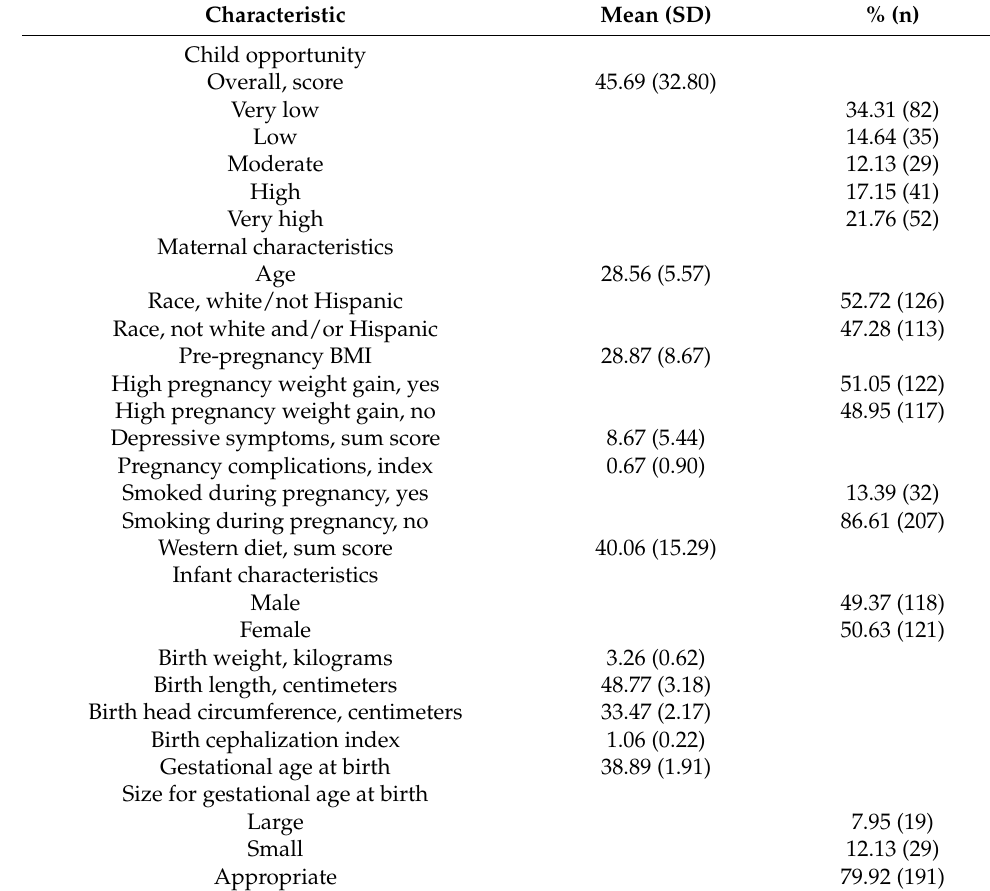
Table 1. Characteristics of the study population ( n =